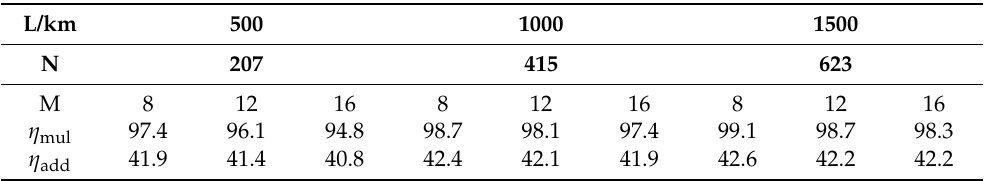
Table 2. The degree of correlation between the calculation amount of real number multiplication η mul and real number addition η add and quantization stages